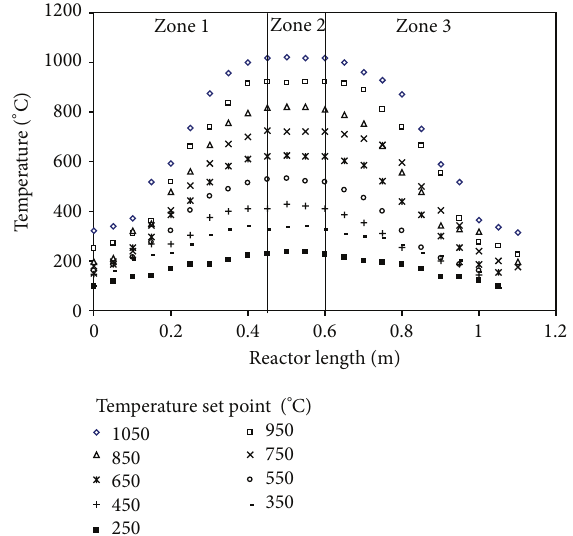
Figure 1: Temperature profiles in a free-fall reactor.